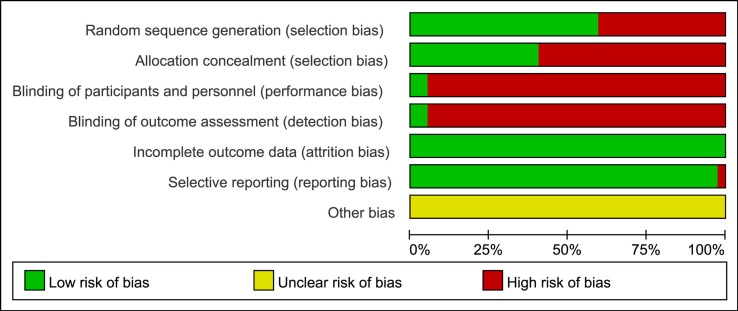
Risk of bias graph.